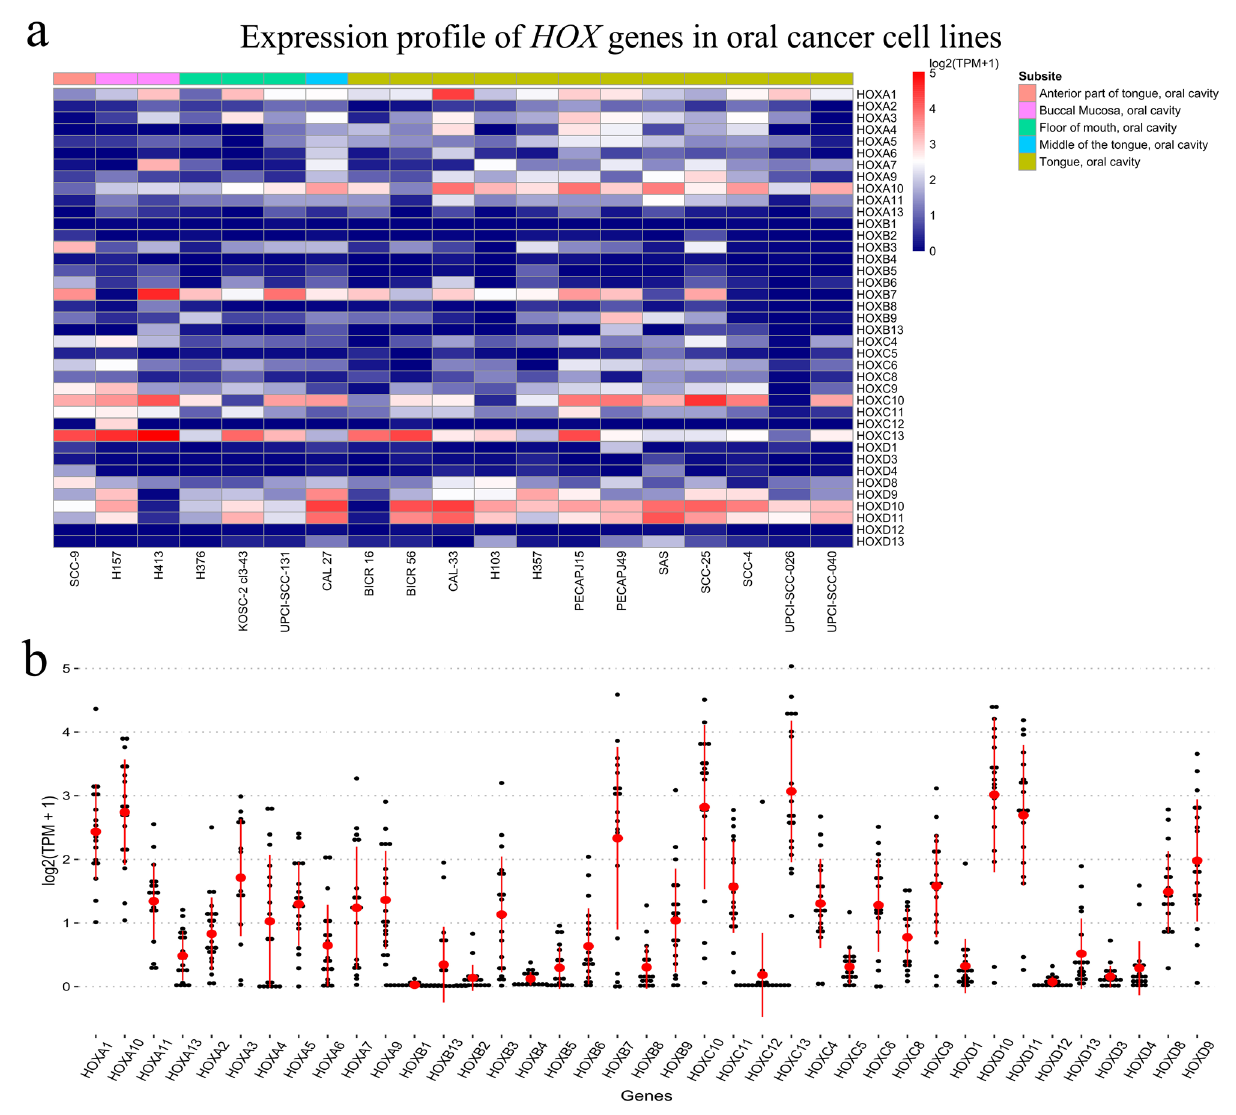
Figure 4. ( a ) Illustrative heatmap depicting the expression level of HOX genes expressed as a log2 (TPM + 1) in a panel of 19 oral cancer cell lines screened. The expression states of HOX genes have been noted to be modestly varied across the cell lines which are in concordance with the clinical data alluding to their biological origin and genomic variation. ( b ) The pooled mean average of the HOX genes in the cell lines is more or less alike to the differentially expressed HOX genes analyzed from the panel of patient